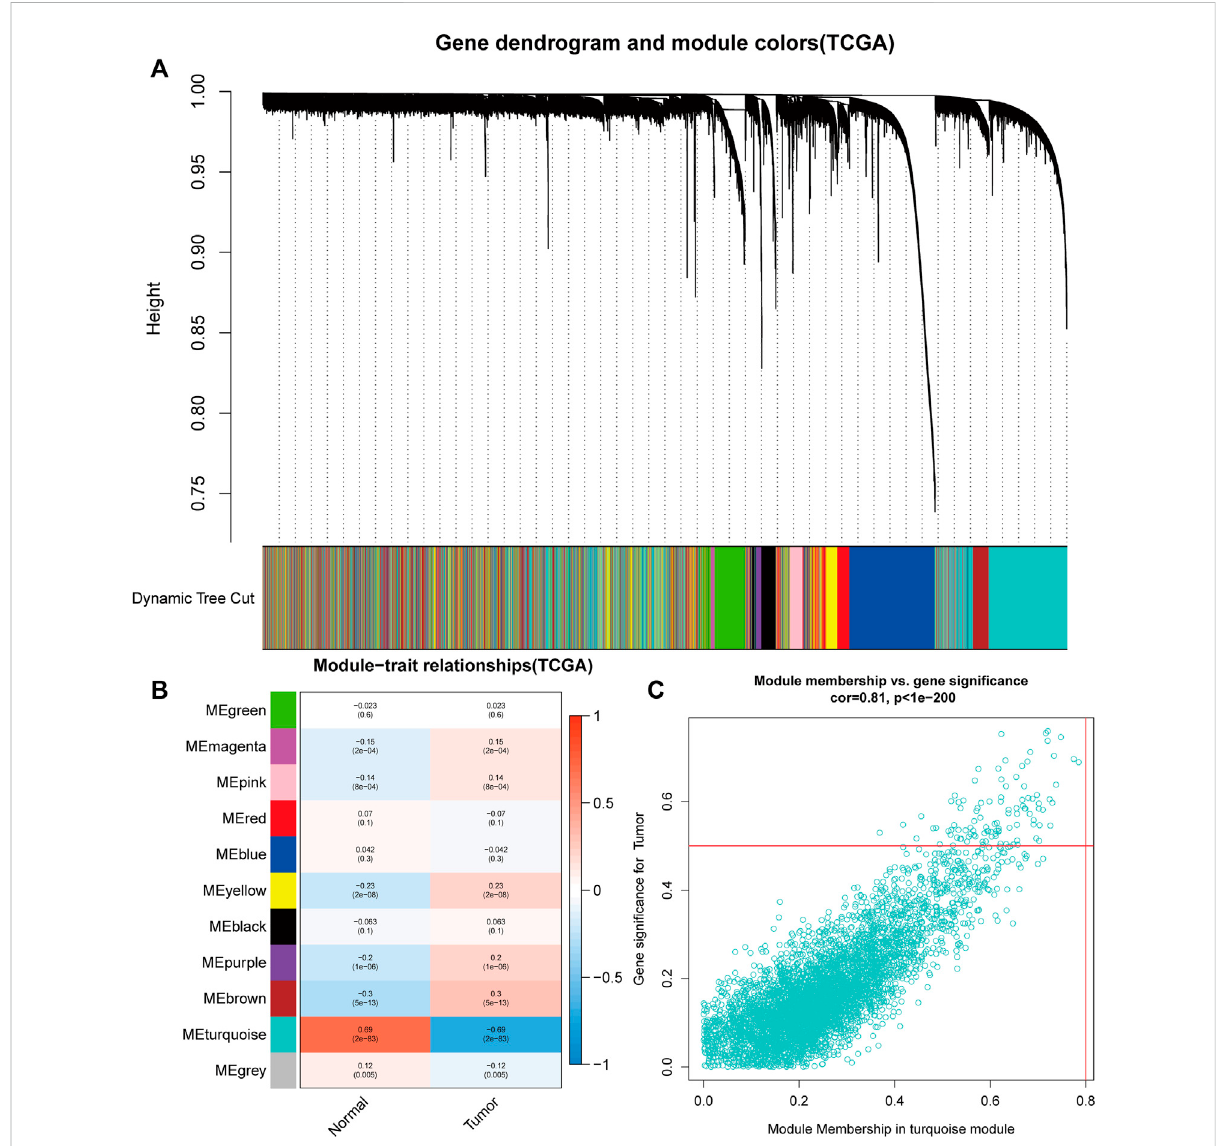
FIGURE 1 Identi fi cation of module data pertaining to the pathological tissue type in TCGA- Uterine corpus endometrial carcinoma (UCEC). (A) Identi fi cation of modules by dynamic tree cutting in TCGA-UCEC. (B) Heatmap of module – trait relationships in TCGA-UCEC. (C) Scatter plots